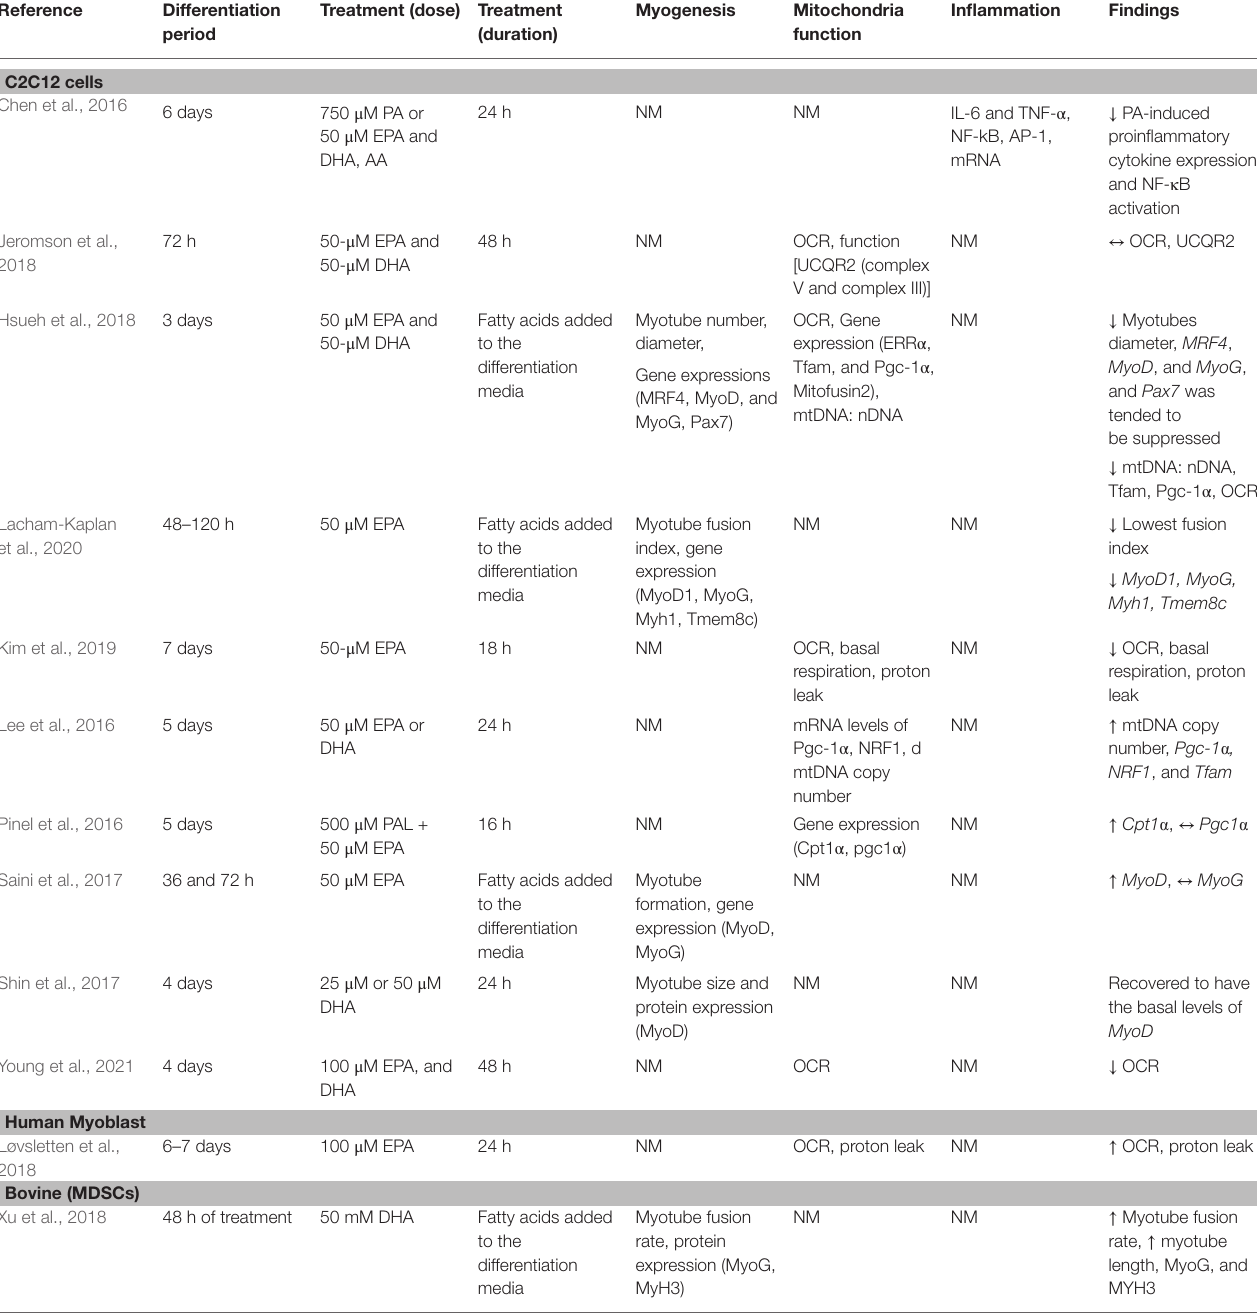
TABLE 1 | Summary of studies that investigated the effects of EPA and DHA on myogenic